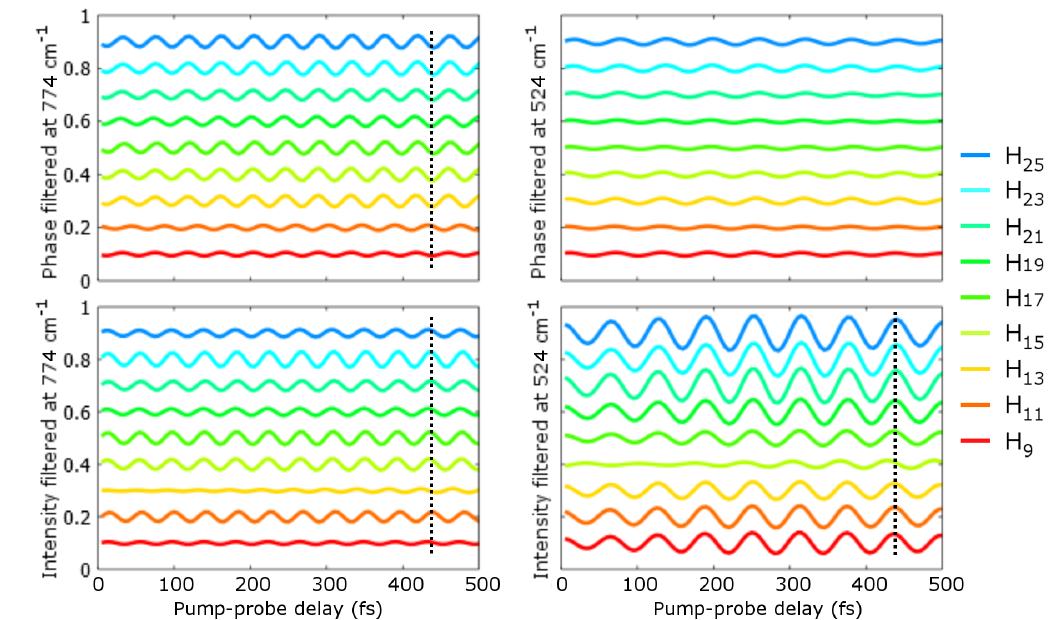
Figure 8. (Color on-line) Phase and intensity of H function of the pump-probe delay filtered at two vibrational frequencies (774 and 524 cm − 1 ). All curves are arbitrarily shifted for clarity. The dashed lines help to visualize the relative phase of the